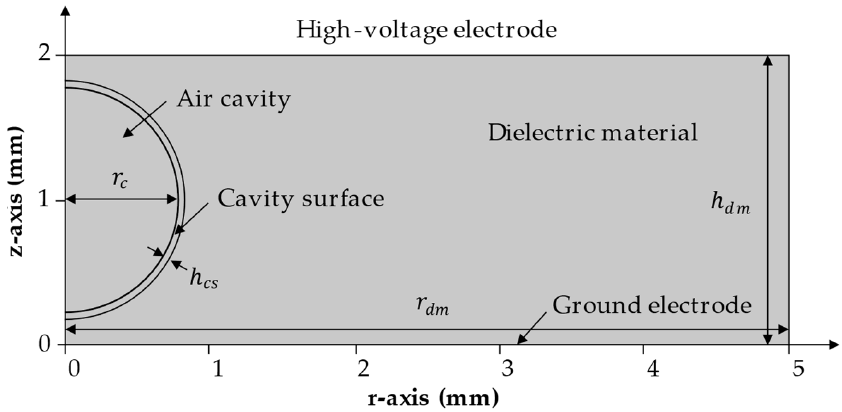
Figure 1. 2D axisymmetric model geometry.